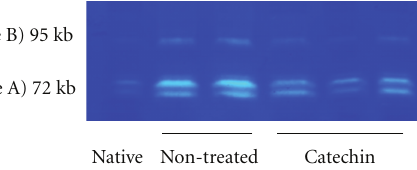
Figure 2: Zymography of myocardial ischemia. Gelatin zymography showed that increased gelatinase (MMP-2 and MMP-9) activity was observed in hearts in the non-treated ischemia group. However, this enhanced gelatinase activity was decreased by catechin administra- tion (20 mg/kg/day, THEA-FLAN